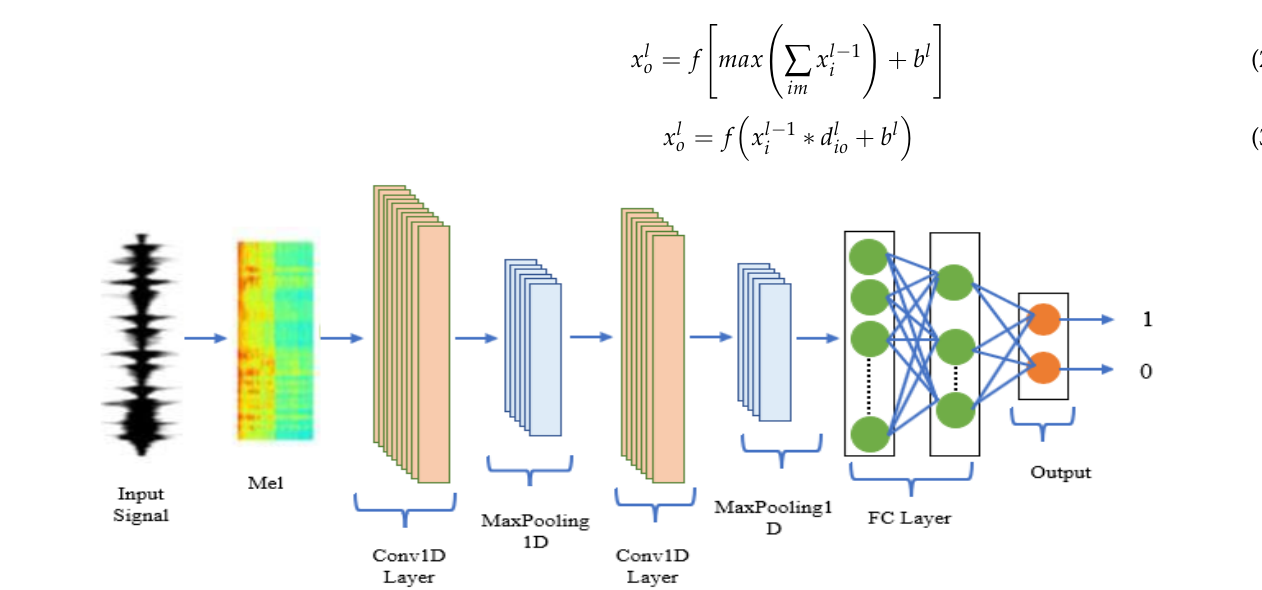
Figure 2. The fundamental design of 1D CNN.